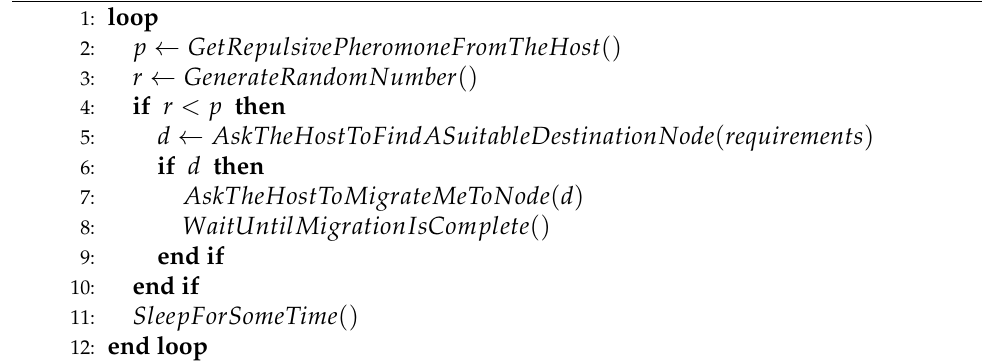
Algorithm A1: Mobile Agent Code Run by Each